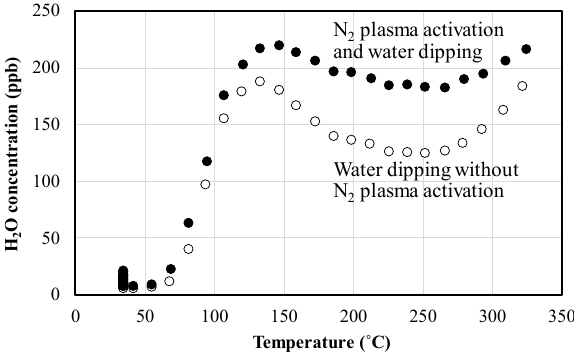
Figure 10. Water storage properties of PE-CVD SiO 2 layers with and without N 2 plasma irradiation.